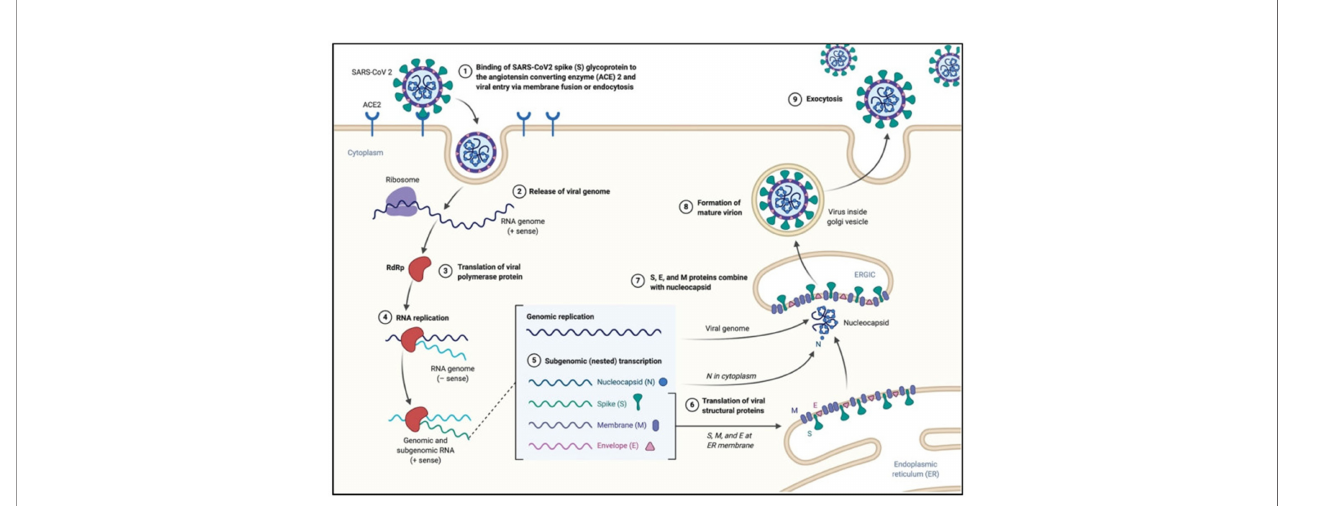
FIGURE 2 | SARS-CoV-2 viral life cycle. The virus binds to the ACE2 receptor, proteolytic cleavage of the spike protein leads to the fusion of the viral envelope with the host membrane, leading to the formation of an endosome, and the release of the viral RNA. The viral polymerase (RNA dependent RNA polymerase RdRp) is translated. The (-)RNA is converted into (+)RNA and the proteins are translated. Non-structural proteins together with the RNA form the RNA-transcription complex. The genomic and subgenomic RNA are produced, and the structural proteins (spike, nucleocapsid, membrane and envelope are translated and new virions assemble at the endoplasmic reticulum). Adapted with permission from Alanagreh et al. (Alanagreh et al.,